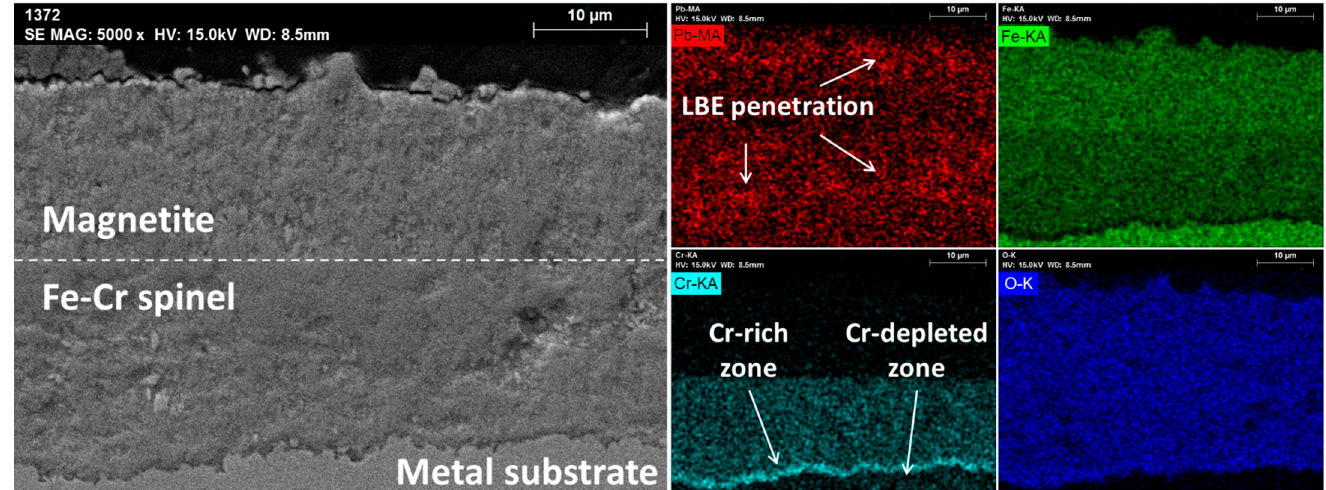
Figure 5. Passive duplex oxide layers formed on T91 after 1000 h at 600 °C. After 2000 h, magnetite and Fe–Cr spinel layers were lost. In some specimens, Cr- rich oxide layers were still found on the metal substrate, as depicted in Figures 6 and 7. Right underneath the Cr-rich oxide, a Cr-depleted zone was observed, similarly to the 1000 h case. Oxygen diffused into the metal substrate boundary, producing the internal Cr-rich oxide along grain boundaries above the Cr-depleted zone. In other specimens, the Cr-rich layer was removed together with the duplex magnetite/Fe–Cr spinel layers. In such cases, LBE penetrated the Cr-depleted zones. Figure 6. Cr-rich spinel layer and a slightly Cr-depleted region on T91 after 2000 h at 600 °C.